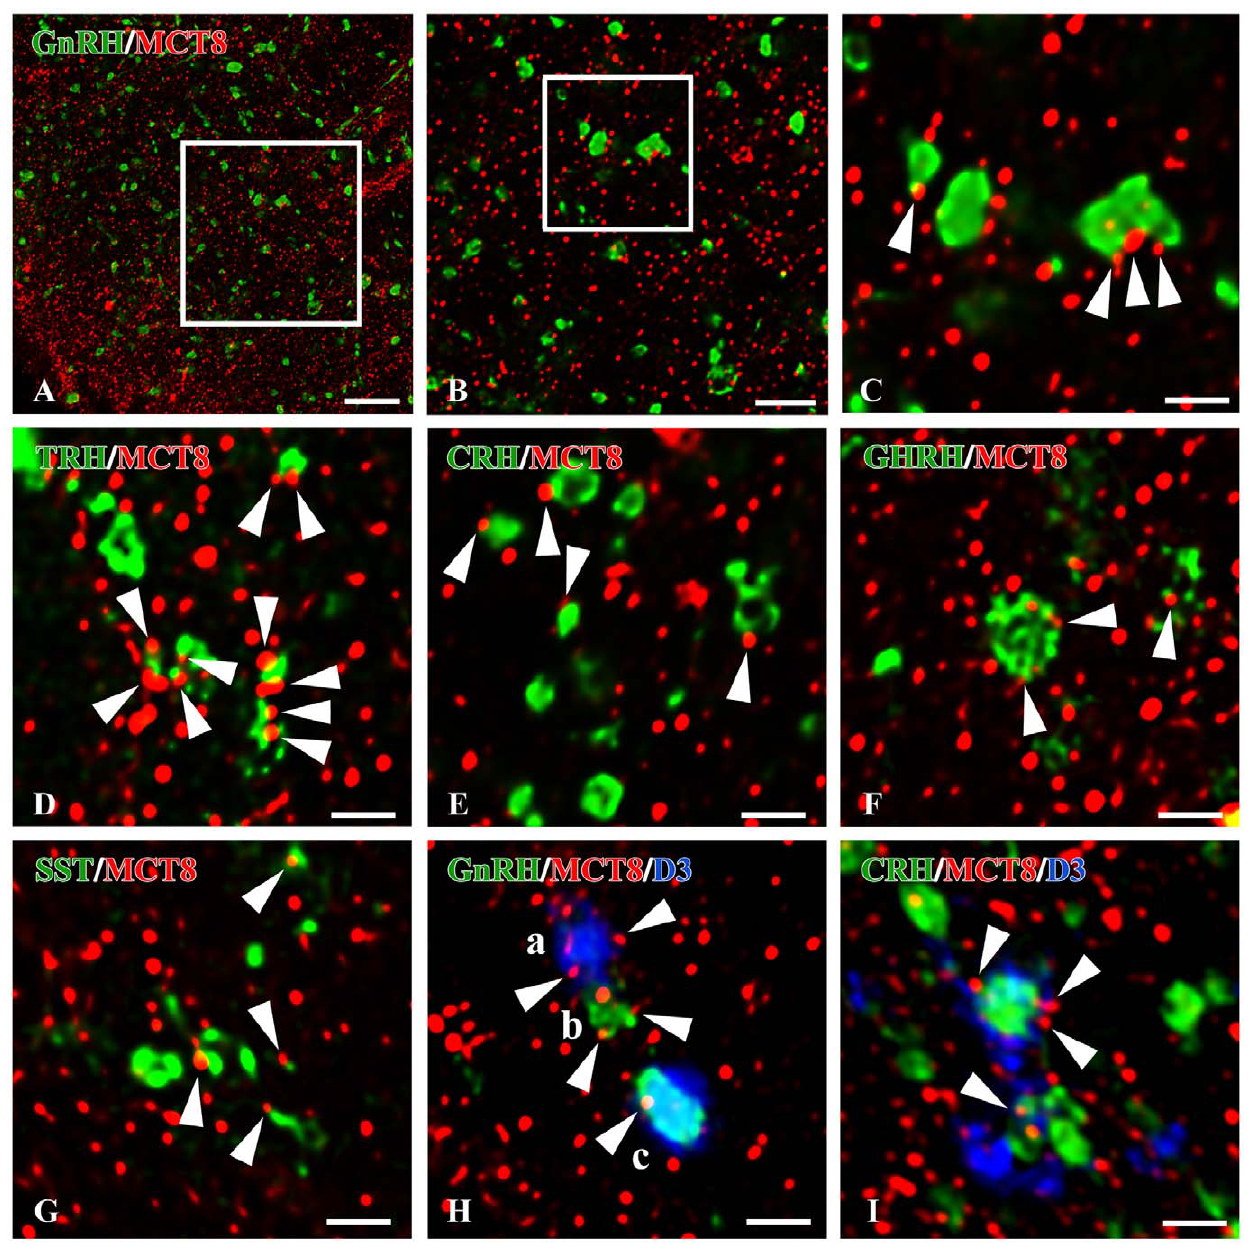
Figure 9. MCT8 and D3 immunoreactivities in axon varicosities of the rat parvocellular hypophysiotropic neurons. Confocal images were subjected to deconvolution. Boxed areas are enlarged in B and C , respectively. The immunofluorescent signal for MCT8 (red) is distributed as small dots throughout the external zone of median eminence and appears (arrowheads) on the surface of gonadotropin-releasing hormone (GnRH, C ), thyrotropin-releasing hormone (TRH, D ), corticotropin-releasing hormone ( E ), growth hormone-releasing hormone (GHRH, F ) and somatostatin (SST, E) immunofluorescent axon varicosities (green). ( H,I ) Representative images of triple immunofluorescent labelings demonstrate D3 (blue), MCT8 (red) and a hypophyseotroph hormone (green) in the axons of the median eminence. MCT8-immunoreactive puncta (arrowheads) appear on the surface of the following categories of axon varicosities; single-labeled for D3 ( Ha ), single-labeled for GnRH ( Hb ), and double labeled for D3 and GnRH ( Hc ) or CRH ( I ). Scale bars: A: 10 m m, B: 5 m m, C-I: 2 m m. doi:10.1371/journal.pone.0037860.g009 priate CY3-conjugated secondary IgG raised in donkeys (1:500, and dichroic/emission filters 560 nm/500–530 nm for Alexa 488 Jackson ImmunoResearch Laboratories, Inc.). and 560–625 nm for Cy3. Pinhole sizes were set to obtain optical slices less than 0.7 m m thick. Colocalization of D3 and the other For quantification of the colocalization of D3 with the peptides were counted in the axon varicosities in the external zone. hypophysiotropic peptide, confocal images were taken from the For each double labeling combination, brain sections from three external zone of the median eminence using 60 X oil immersion animals were used. One randomly selected microscopic field objectives. The fluorochromes were detected with the following (2600 m m 2 each) from the external zone of median eminence of laser lines and filters: 488 nm for Alexa 488 and 543 nm for Cy3